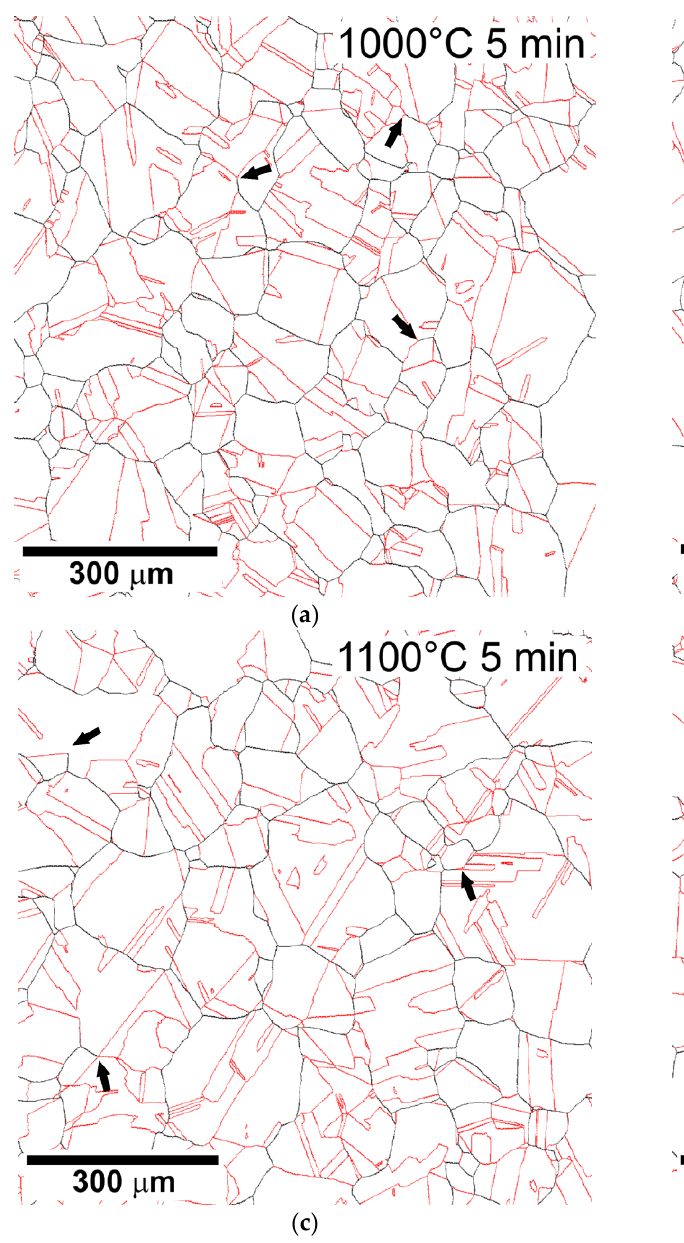
Figure 4. Grain boundary network in the steel samples annealed at 1000 ◦ C for 5 min ( a ), at 1000 ◦ C for 50 h ( b ), at 1100 ◦ C for 5 min ( c ), and at 1100 ◦ C for 10 h ( d ). Black and red lines indicate ordinary and ∑ 3 n CSL boundaries,